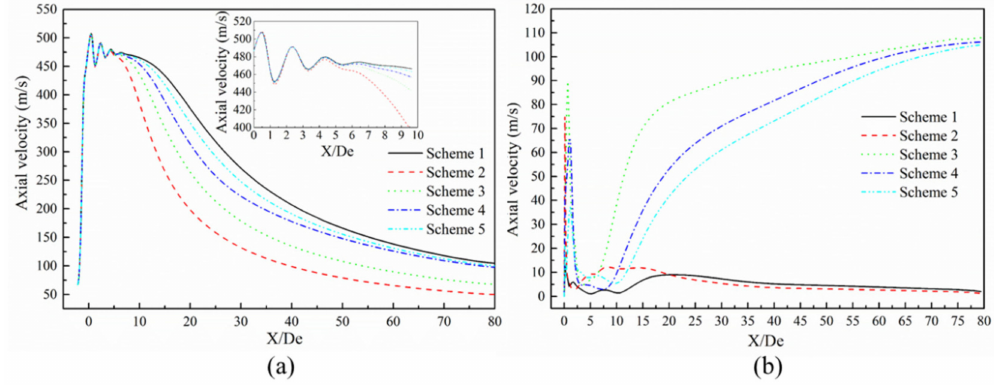
Figure 8. Axial velocity distribution of the supersonic jet. ( a ) Laval nozzle and ( b ) lance tip.